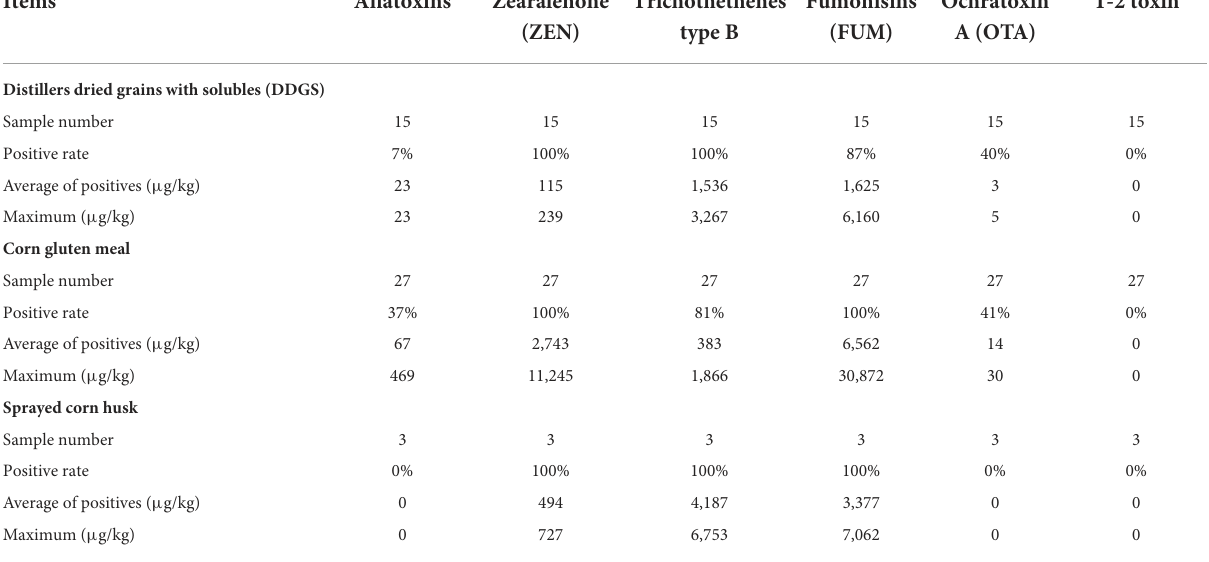
TABLE 3 Mycotoxin occurrence in corn